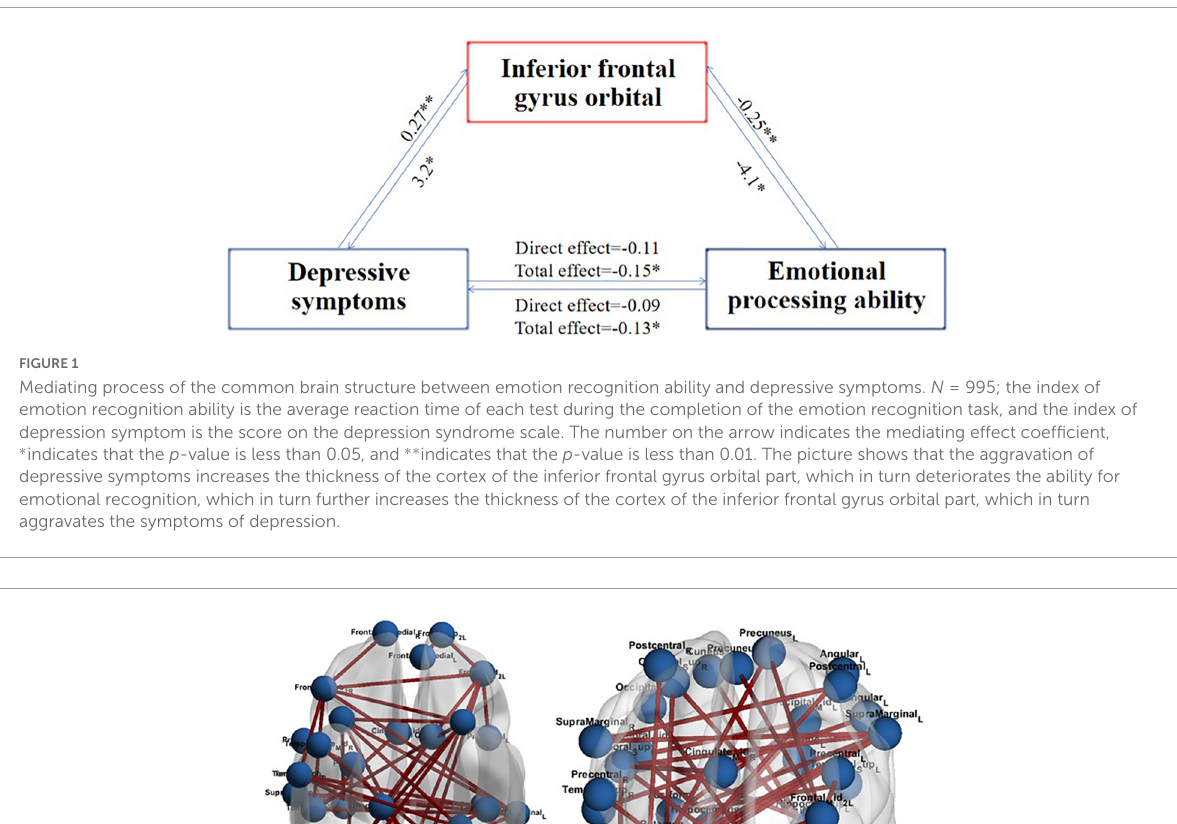
emotion recognition ability had stronger spontaneous activity, higher consistency and lower synchrony of spontaneous activity in the orbital part of the inferior frontal gyrus and the lateral orbitofrontal gyrus. And then, resting-state FC strength